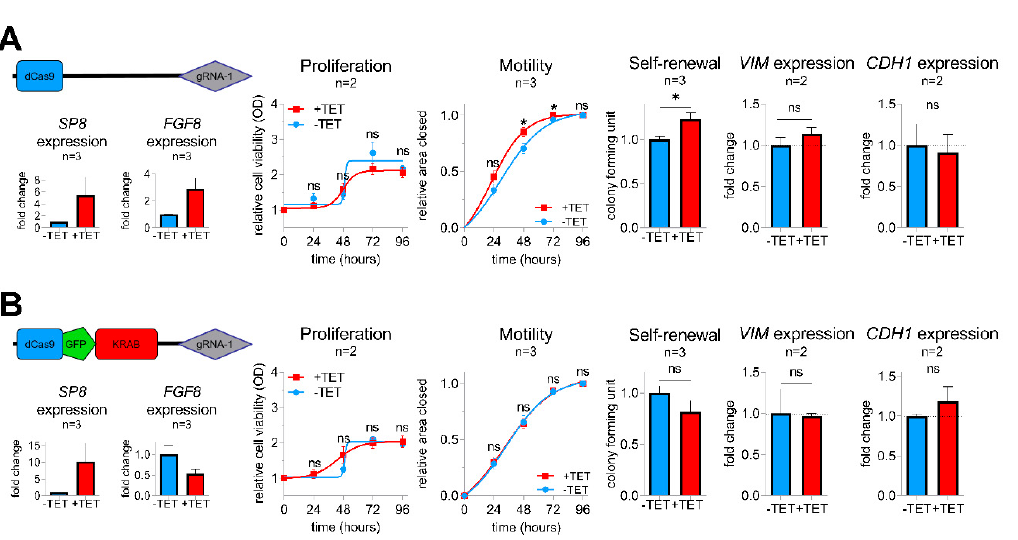
Figure 4. Vectors for dCas9 ( A ) and dCas9-GFP-KRAB ( B ) expression used for the CRISPR-Cas9 interference-mediated FGF8 knockdown with guide RNA 1 directed against FGF8 . SP8, FGF8, VIM, and CDH1 mRNA expression was measured using Q-PCR and normalized to the housekeeping gene TBP . Proliferation, motility, and colony formation assays of TET-induced and non-induced Hep3B pool cells in the presence of either the pPlat-dCas9-gRNA-1 control vector (upper panel) or the knockdown mediating pPlat-dCas9-GFP-KRAB-gRNA-1 vector (lower panel). Means ± SEM were calculated from the indicated number of independent experiments. Statistical significance of all experiments was calculated using a t-test (* p < 0.05).